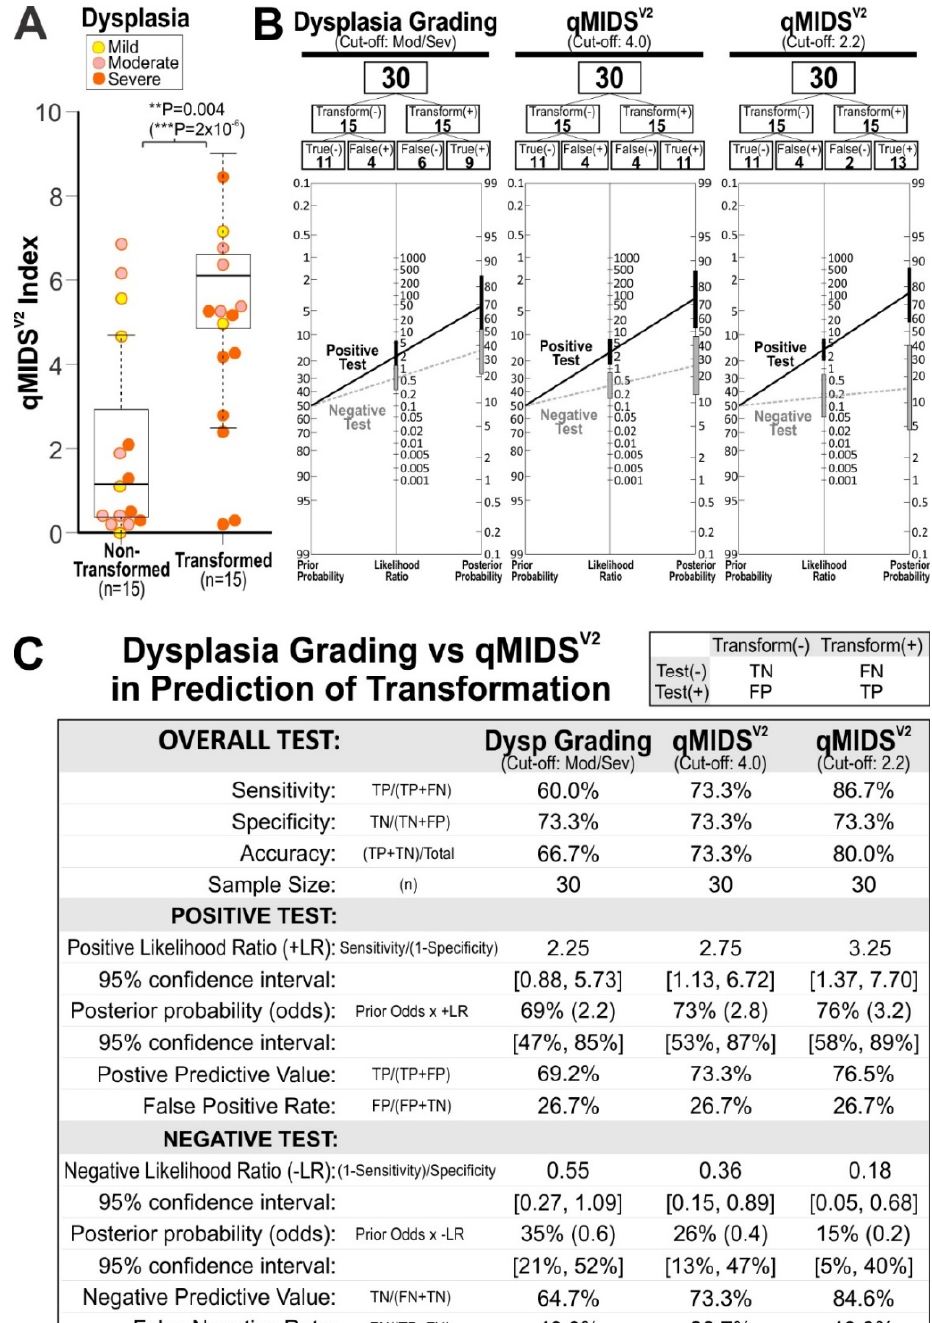
negative rate of dysplasia grading from 40% to 26.7%. If the cut-off values were lowered to 2.2 (an optimal cut-off level in this dataset), qMIDS V2 could further reduce false-nega- tive rate to 13.3% while increasing test sensitivity from 60.0% to 86.7% and accuracy from 66.7% to 80.0% (Figure 5B,C).